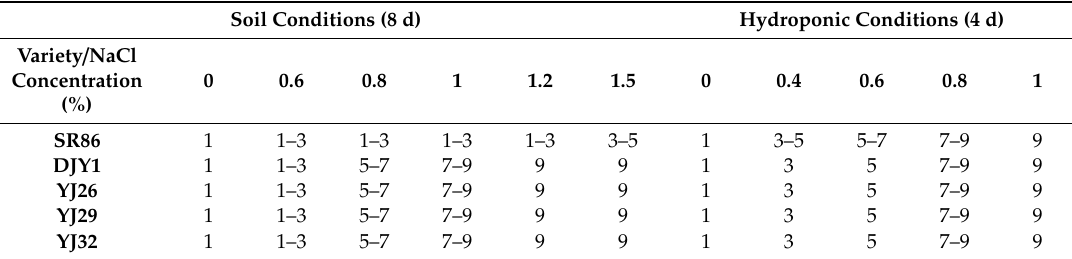
Table 1. The grades of di ff erent rice varieties under soil and hydroponic